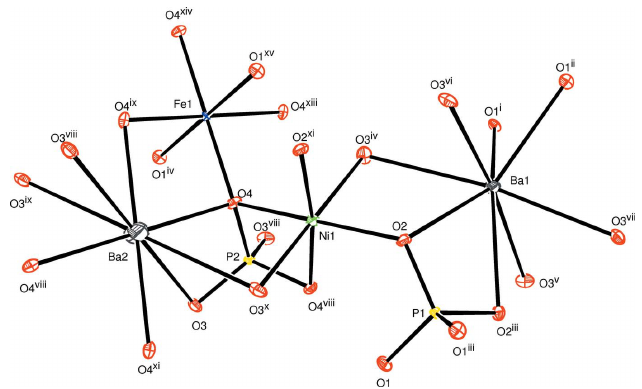
Figure 1 The principal building units in the crystal structure of the title compound. Displacement ellipsoids are drawn at the 50% probability level. [Symmetry codes: (i) (cid:4) x + 1, (cid:4) y + 1 , z (cid:4) 1; (ii) x , y , z (cid:4) 1; (iii) (cid:4) x + 1, 2 (cid:4) y + 1 , z ; (iv) (cid:4) x + 3 , (cid:4) y + 1, z (cid:4) 1 ; (v) x (cid:4) 1 , y (cid:4) 1 , z (cid:4) 1 ; (vi) (cid:4) x + 3 , y (cid:4) 1 , 2 2 2 2 2 2 2 2 z (cid:4) 1 ; (vii) x (cid:4) 1 , (cid:4) y + 1, z (cid:4) 1 ; (viii) (cid:4) x + 2, (cid:4) y + 1, (cid:4) z + 2; (ix) (cid:4) x + 2, y , 2 2 2 z ; (x) x , (cid:4) y + 1, (cid:4) z + 2; (xi) (cid:4) x + 3 , (cid:4) y + 1 , (cid:4) z + 3 ; (xii) (cid:4) x + 3 , y , (cid:4) z + 3 ; 2 2 2 2 2